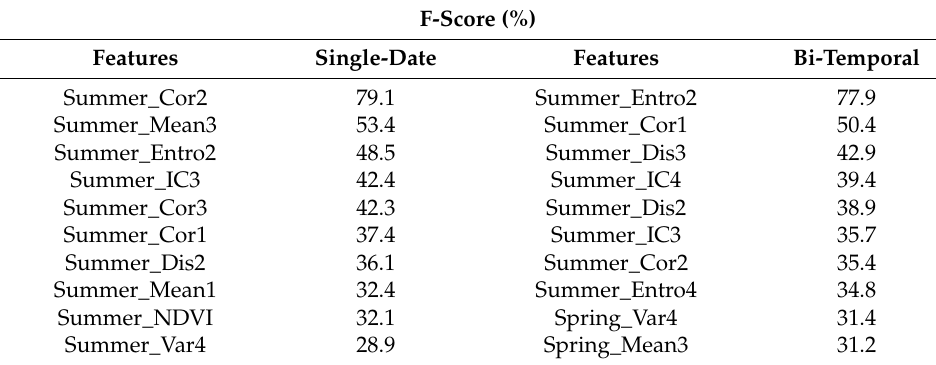
Table 6. F-score values of the ten most important features in the single-date classification and the bi-temporal classification using SVM